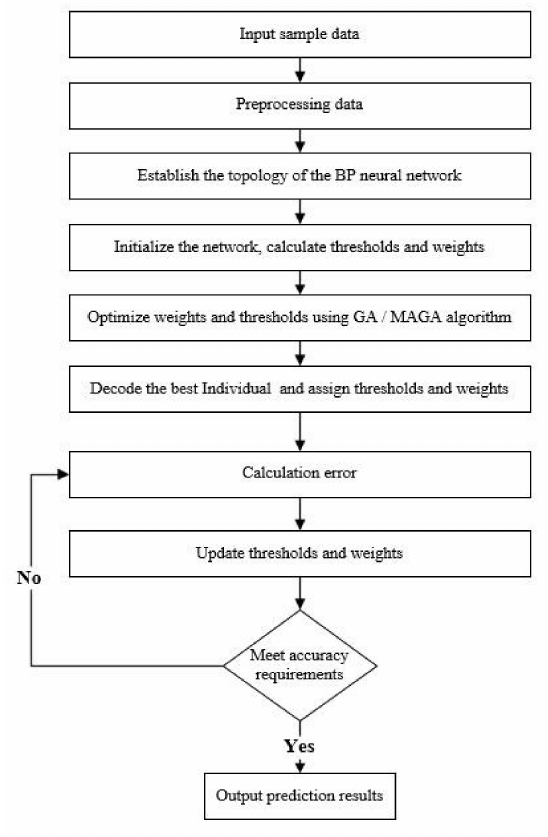
Figure 9. The flow chart of BP neural network optimized by GA /